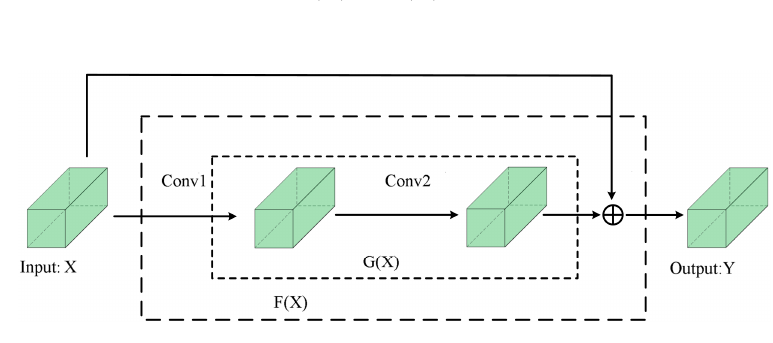
Figure 1. Illustration of a residual block.